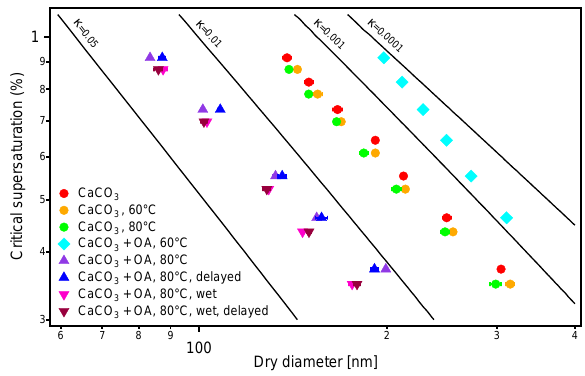
Figure 5. Critical dry diameters at different supersaturations (SS) of polydisperse CaCO 3 aerosol before (circles) and after oleic acid (OA) coating. Experiments were performed at 60 ◦ C (turquoise di- amond) and 80 ◦ C (triangles) coating temperatures. The flow tube experiments at 80 ◦ C were performed (indicated by “delayed”) at dry conditions (normal, blue triangles) and at enhanced water va- por (“wet”, brown triangles). The effect of the temperature in the coating device on the CaCO 3 core is negligible (red, green, and orange circles). As for the monodisperse case in Fig. 4, at 60 ◦ C coating temperature the particles are less CCN active than bare CaCO 3 while at 80 ◦ C the coated particles are more CCN active. The presence of water vapor (1500Pa) in the coating process en- hances CCN activity. The increasing of residence time (23.7s) of the coated aerosol in the flow tube had no significant effect on CCN activity in both